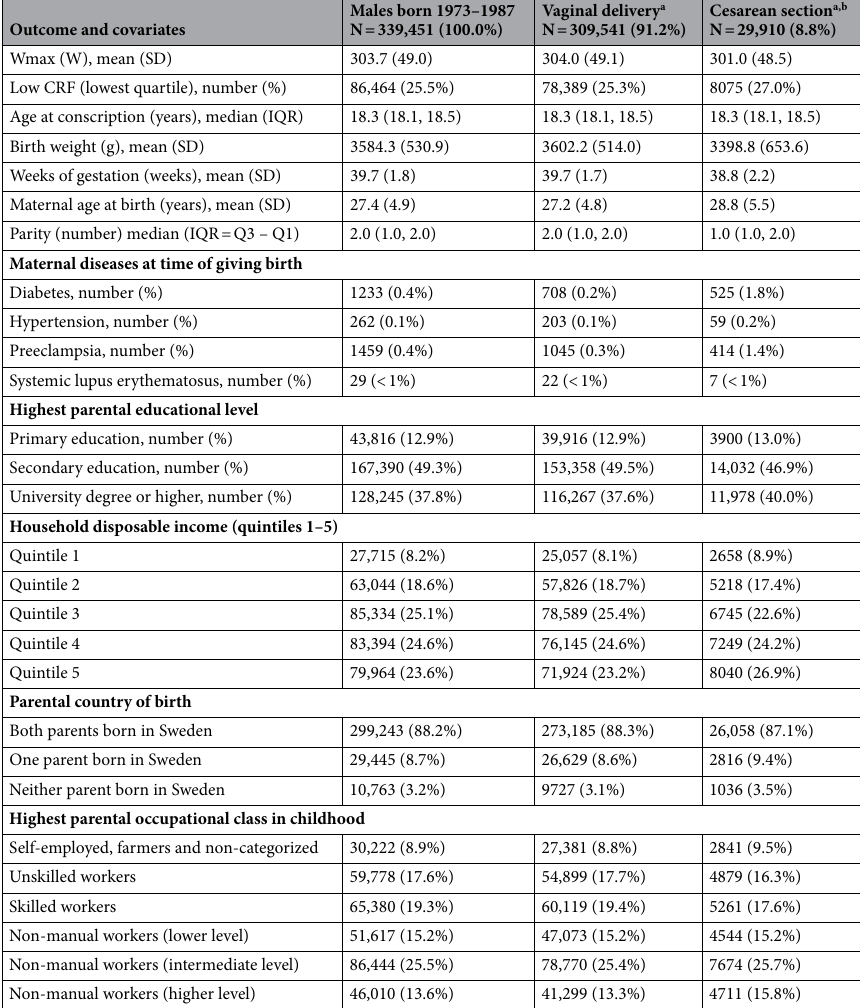
Table 1. Population characteristics main analytic sample (males born 1973–1987) by exposure category. a Exposure in the main analytic sample was defined as males born by cesarean section (elective and non-elective undifferentiated) and were compared to males born vaginally. b Cesarean section shows non-differentiated CS (elective and non-elective CS